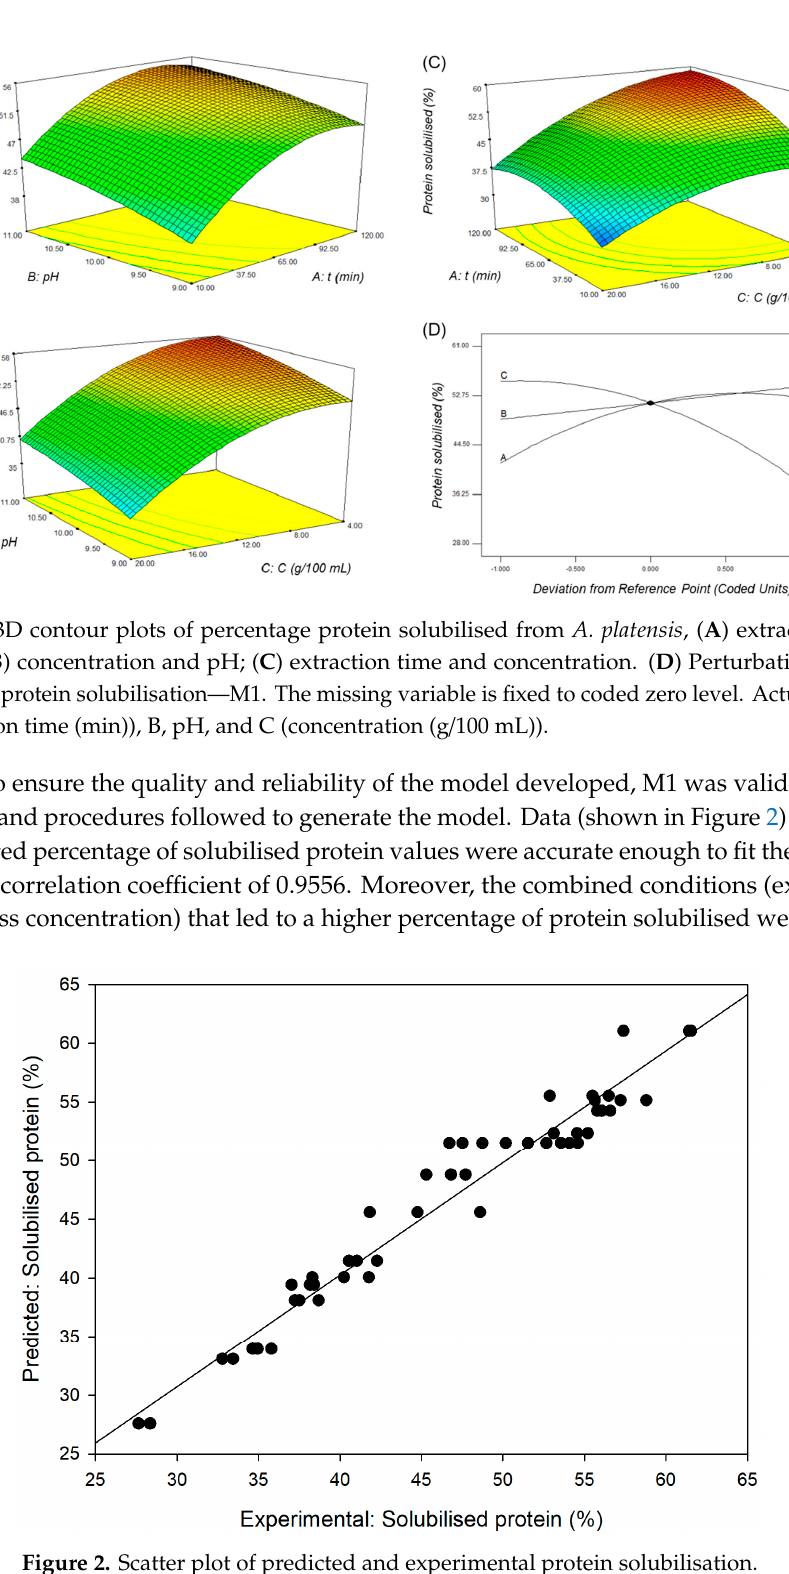
Figure 2. Scatter plot of predicted and experimental protein solubilisation.